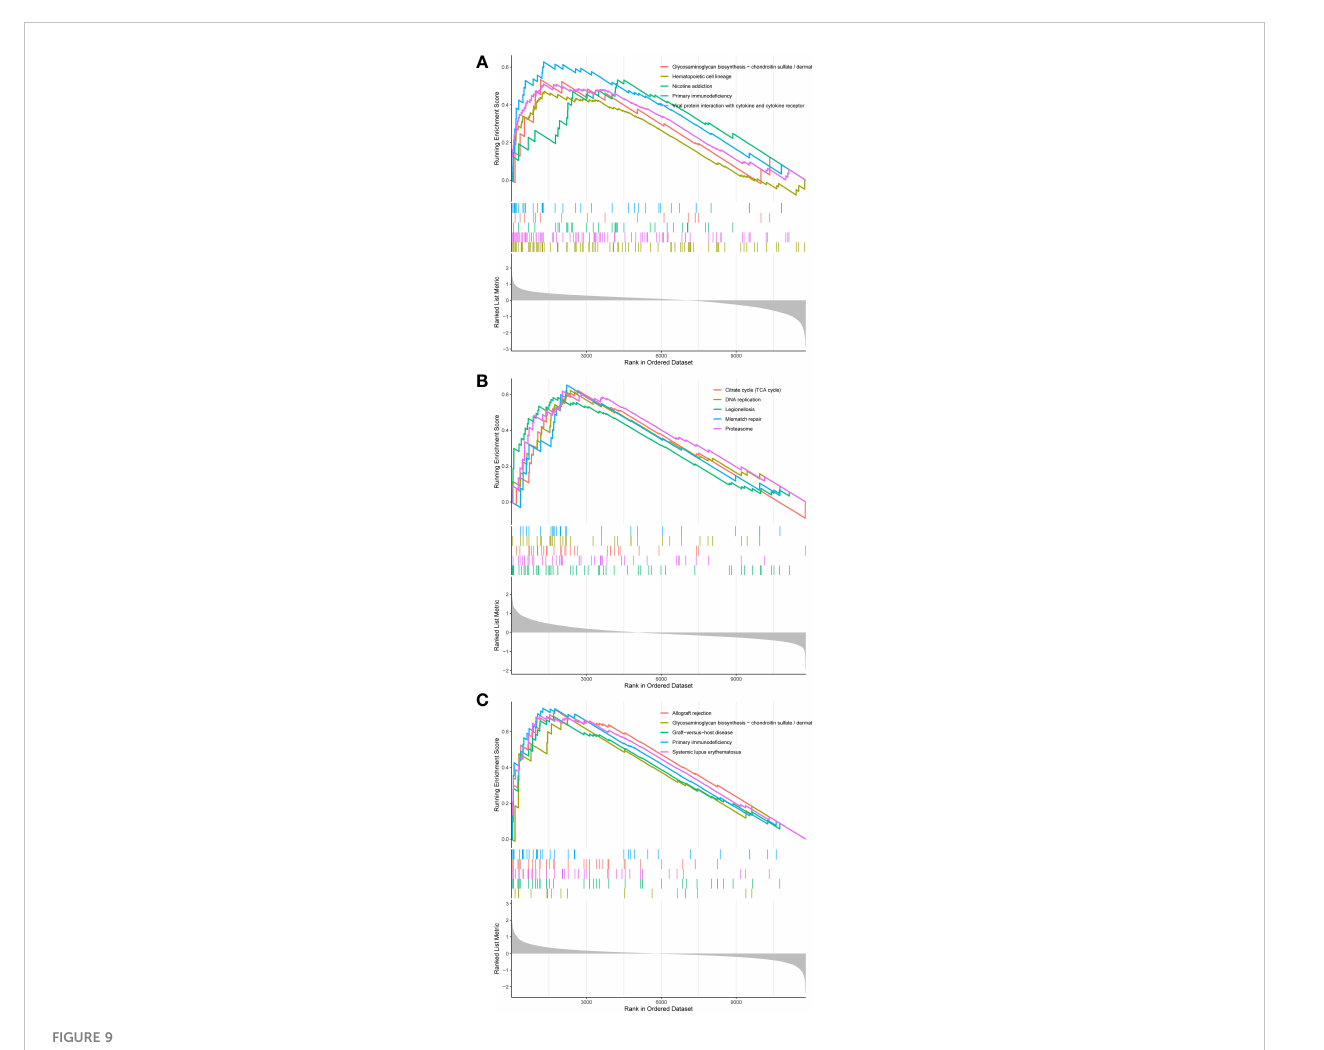
FIGURE 9 (A-C) GSEA analysis of hub